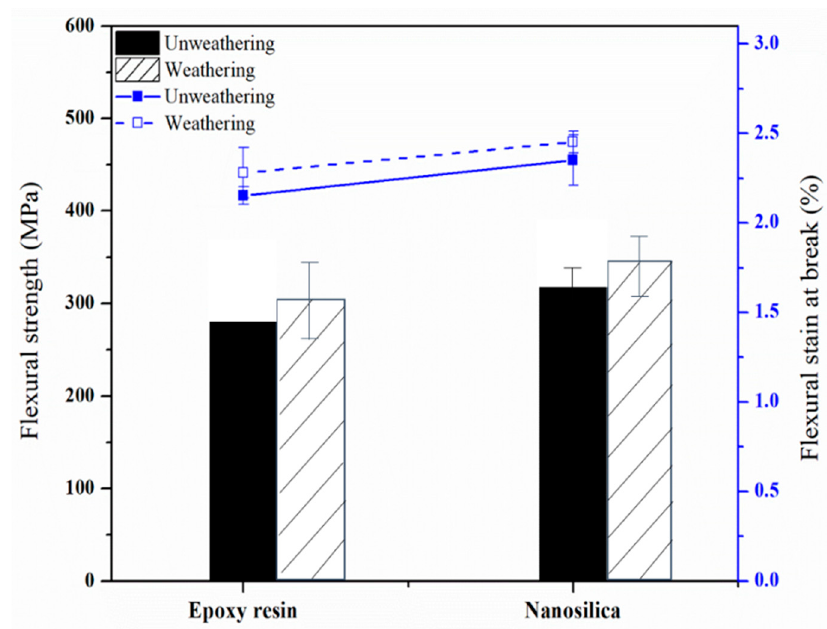
Figure 6. Flexural strength of nanocomposites-fiber samples after accelerated aging.